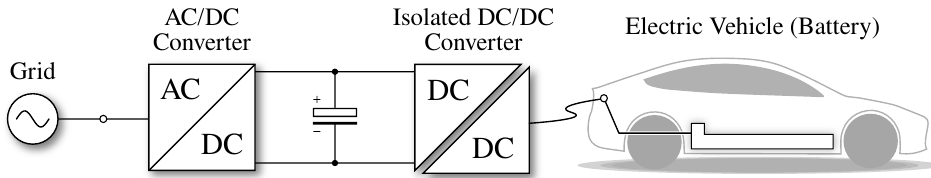
Figure 3. Simplified schematic of an off-board DC fast-charger.